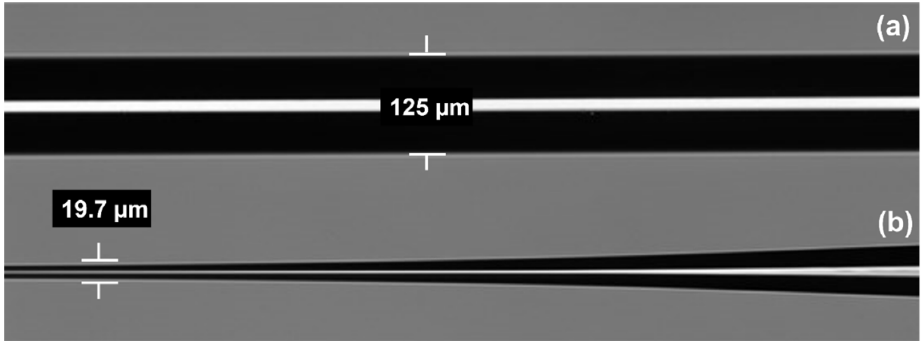
Figure 2. A sketched figure of tapered fiber profile with a uniform waist.